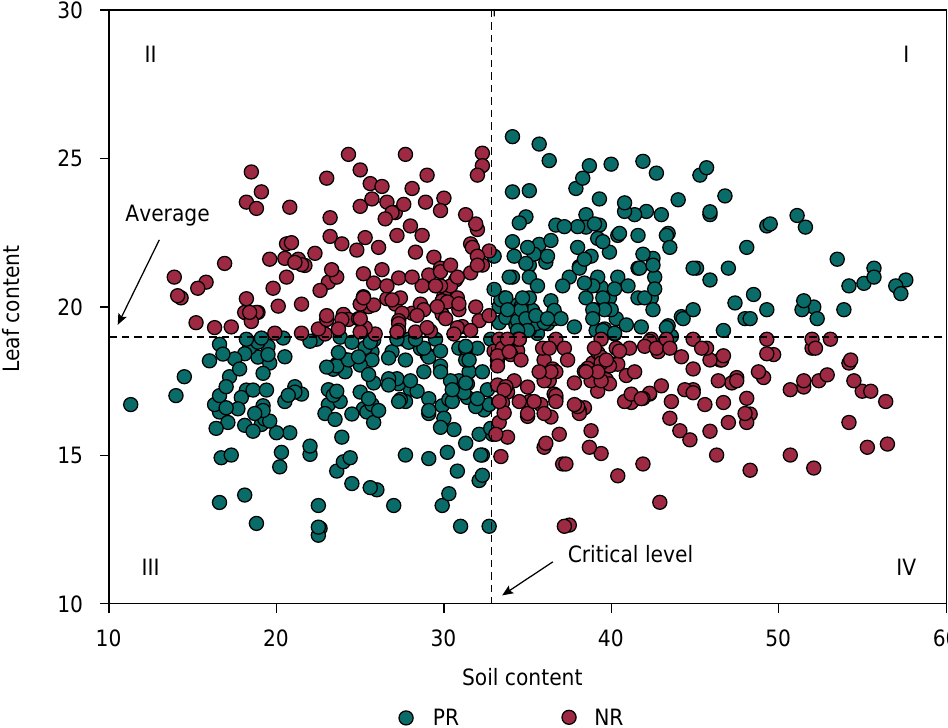
Figure 2. Scatter diagram illustrating the application of the Quadrant Diagram of the plant-soil Relationship (QDpsR) method, obtained from the relationship between nutrient concentrations in the leaf (y) and in the soil (x). PR: Positive response; NR: Neutral